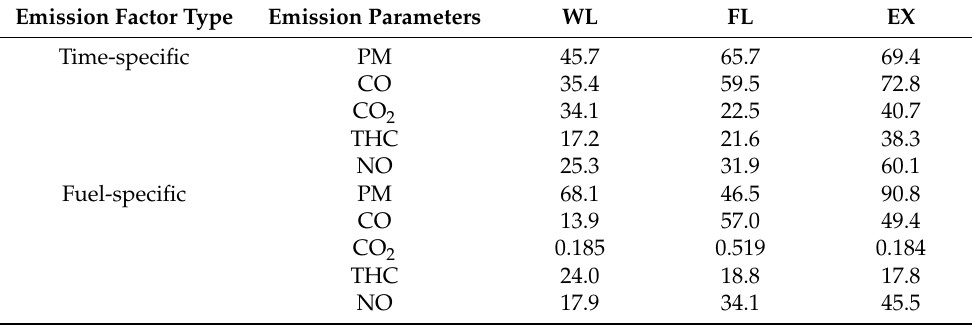
Table 3. Coefficient of variation (%) of time-specific and fuel-specific emission